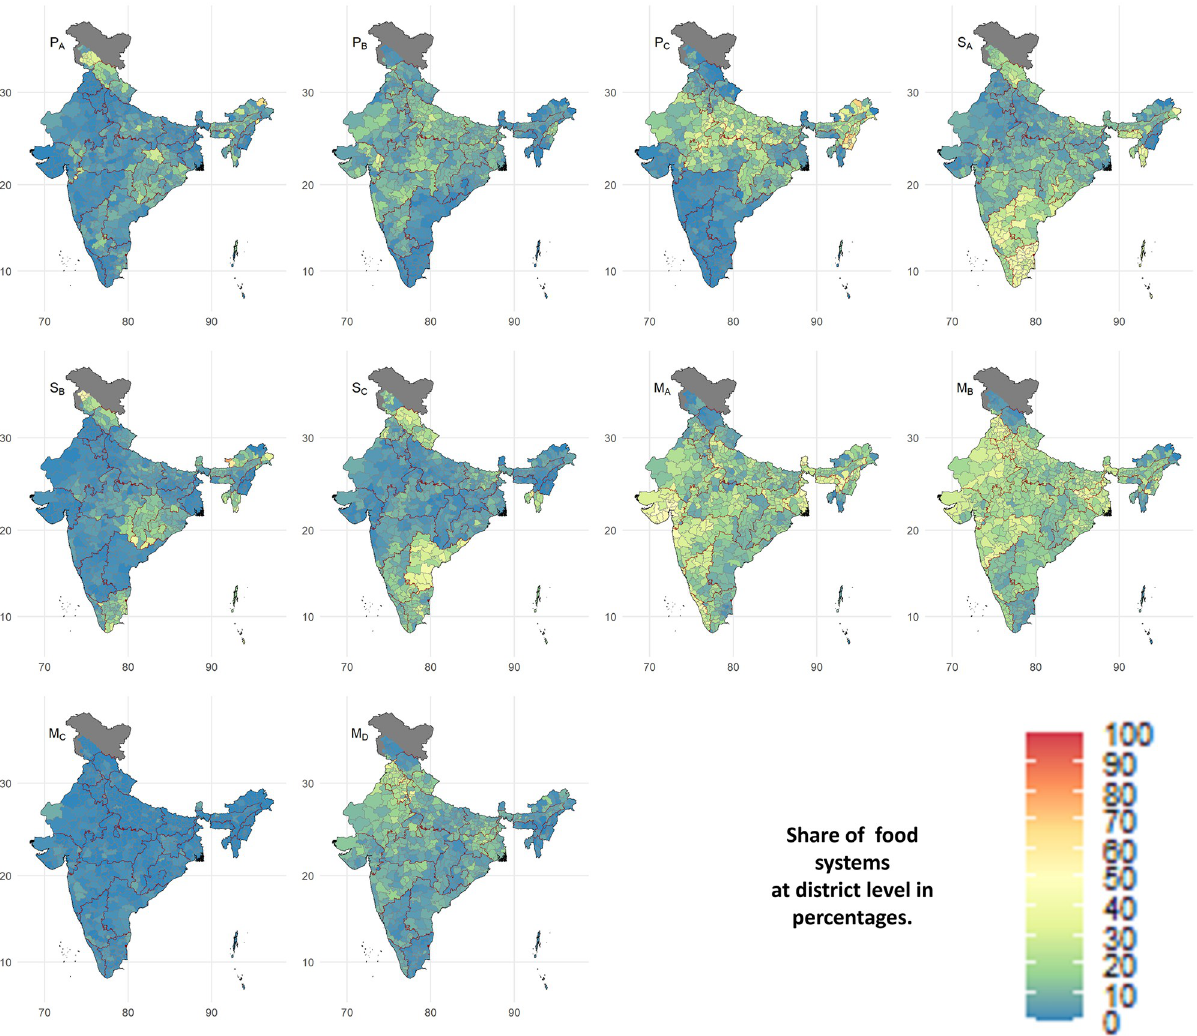
Fig 1. Spatial distribution of Indian food systems. The figure describes the percentage share of 10 food systems at the district level. Two states (Andhra Pradesh and Jammu and Kashmir), bifurcated after 2011–12, are considered original states. The data for three districts of Jammu and Kashmir state, i.e., Leh(Ladakh), Kargil, and Poonch, were not available.